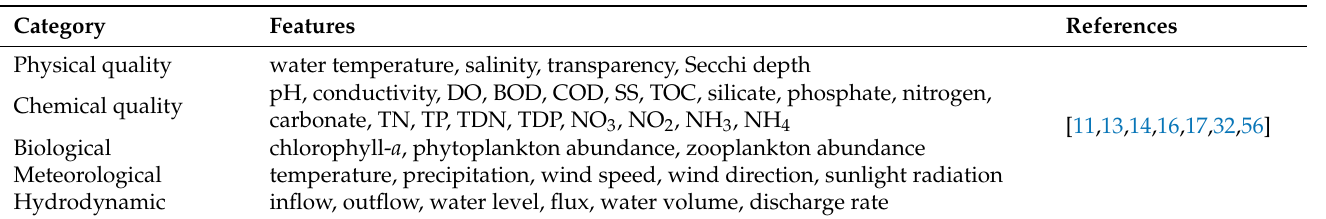
Table 5. Variables used for the predictions of the Chl- a concentration and algal blooms using machine learning methods. Abbreviations: BOD, biochemical oxygen demand; COD, chemical oxygen demand; SS, suspended solids; TOC, total organic carbon; TN, total nitrogen; TP, total phosphorus; TDN, total dissolved nitrogen; TDP, total dissolved